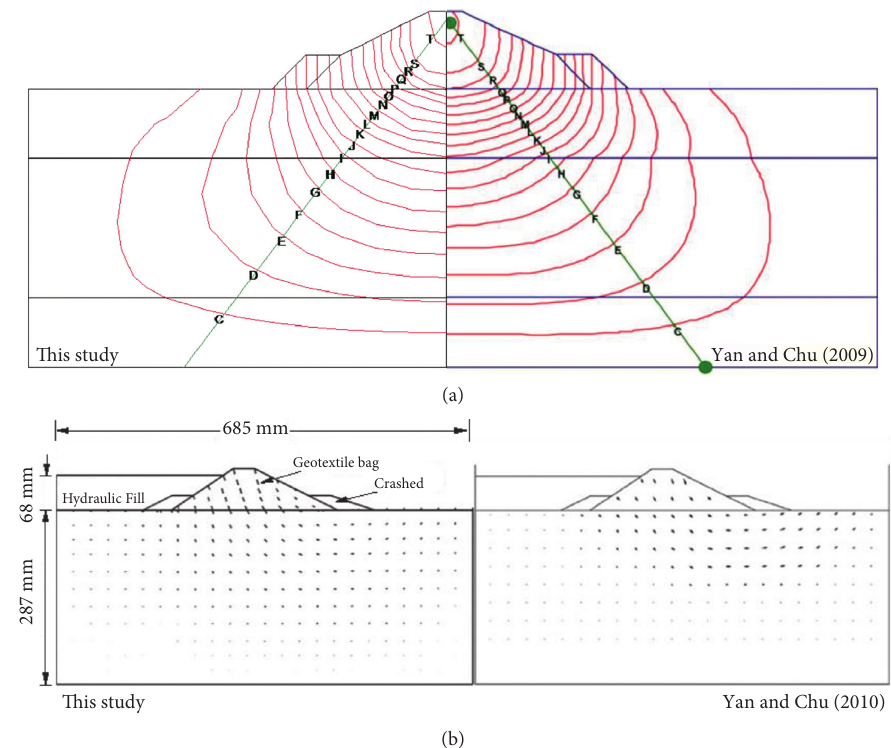
Figure 4: Validation of the numerical study against Yan and Chu (2009): (a) validation of settlement for numerical simulation: C ∼ T, Disp � 0.025m ∼ 0.450 m; (b) validation of soil flow mechanism against the centrifuge